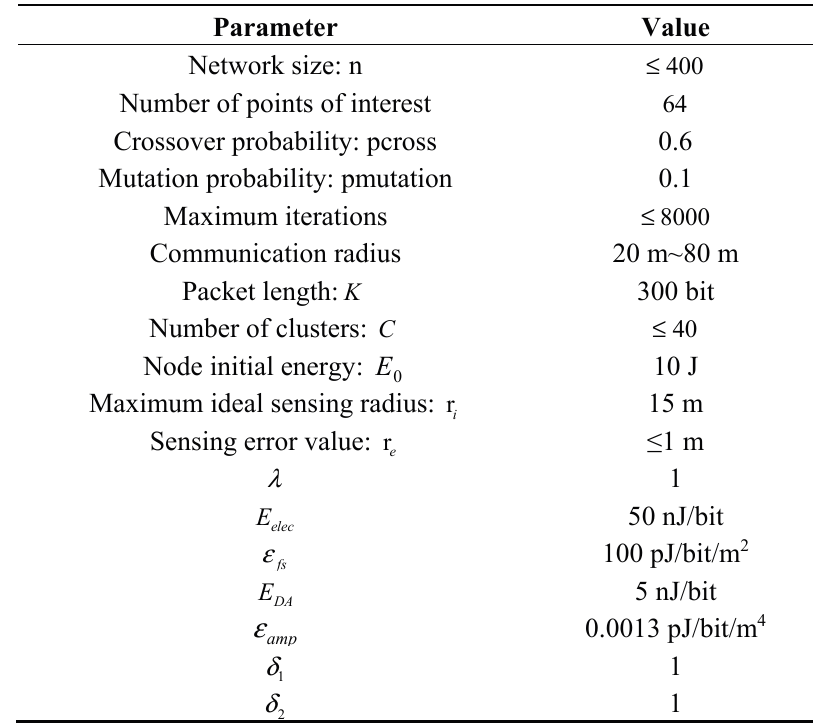
Table 1. Parameters used in simulations